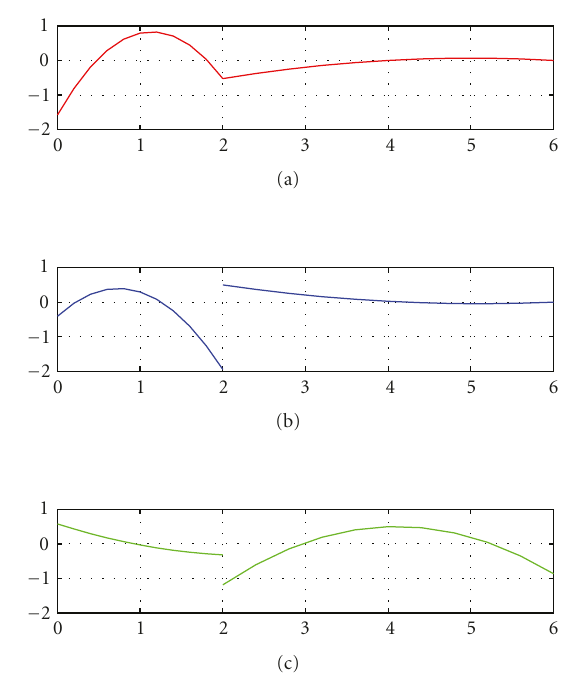
Figure 8: Orthonormal quadratic wavelet basis (no particular con- ditions).